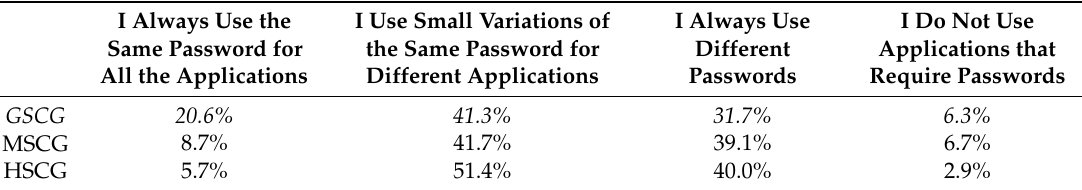
Table 11. For applications that require a password.